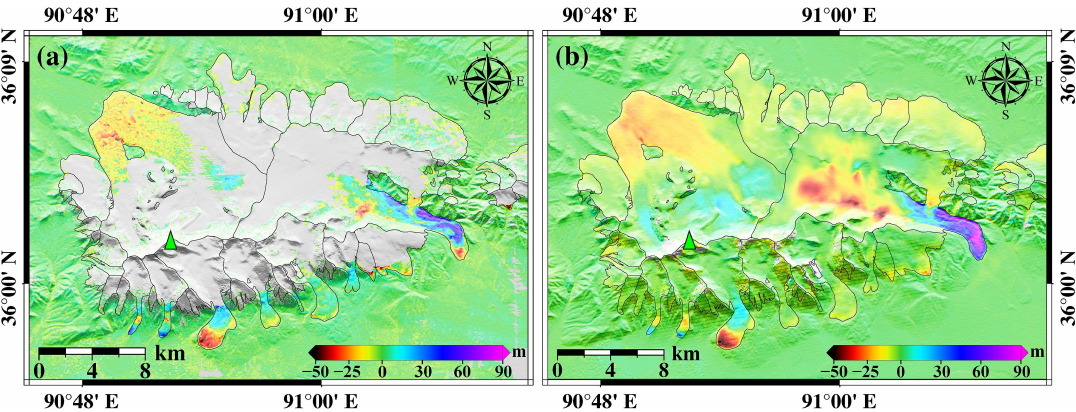
Figure 2. Changes of glacier thickness in the Bukatage Massif. ( a ) In 2000–2010 (PRISM digital elevation model (DEM)–C-band shuttle radar tomography mission (SRTM-C) DEM) and ( b ) 2000–2012 (TanDEM-X DEM–SRTM-C DEM). Black lines: glacier outlines; backgrounds: shaded SRTM-C DEM; green triangle in each image: